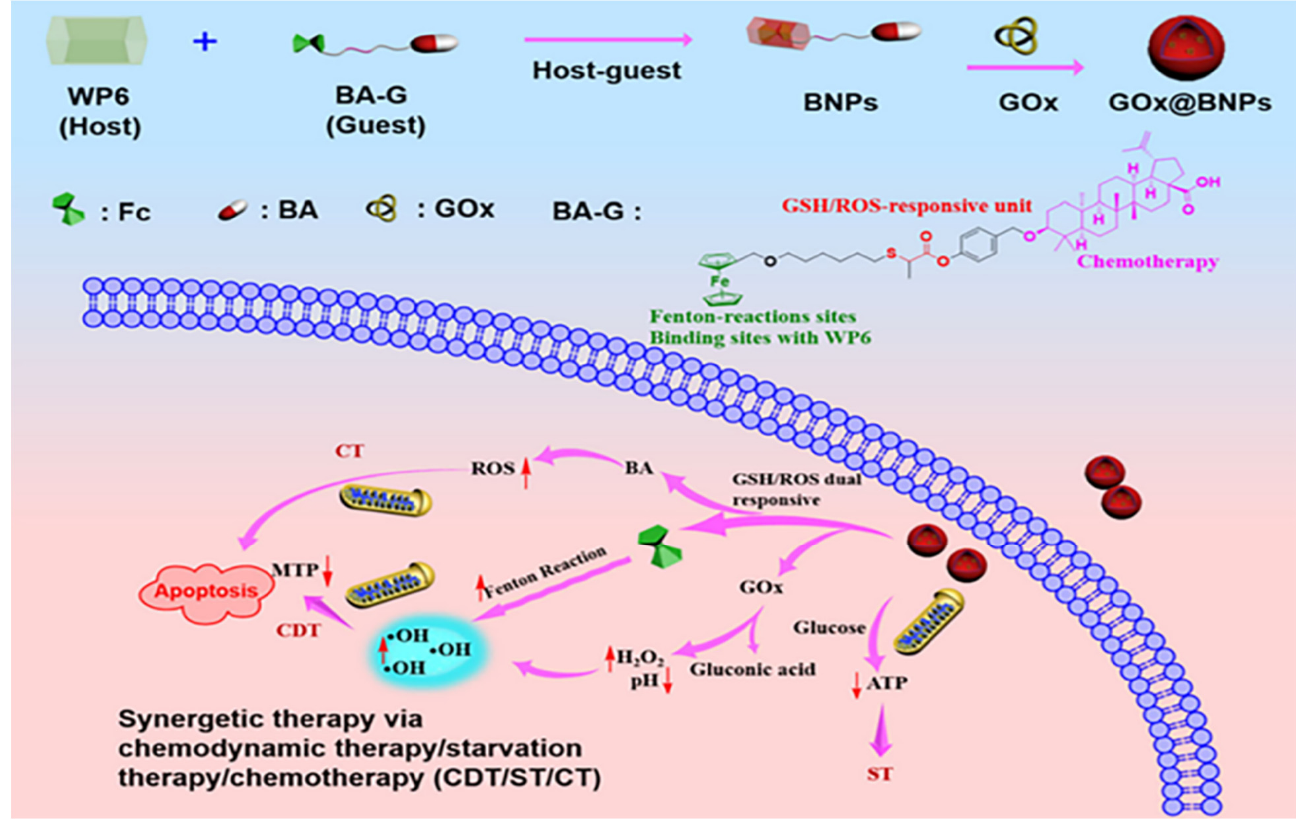
Figure 11. The assembly GSH/ROS dual-responsive supramolecular nanoparticles (GOx@BNPs) (reproduced with permission of MDPI AG from ref. [78]).